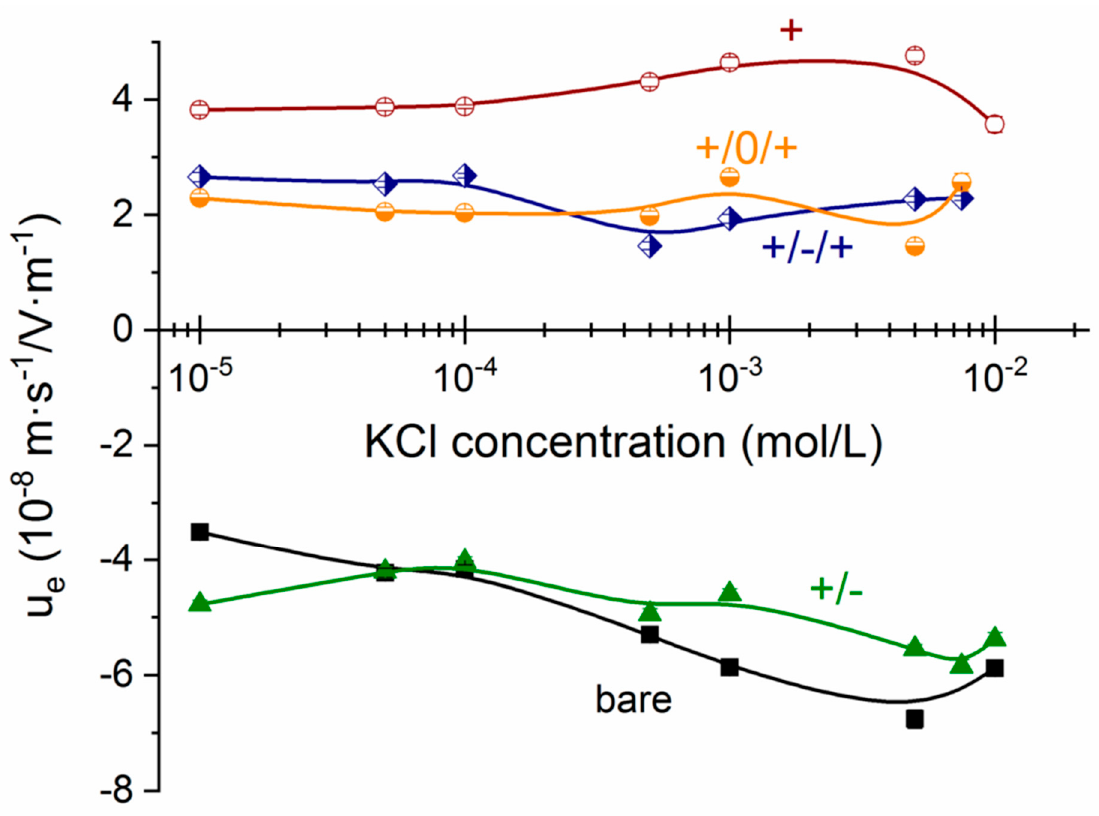
Figure 9. Electrophoretic mobility (DC field) as a function of KCl concentration for the particle systems studied. Points: experimental data. Lines a guide to the